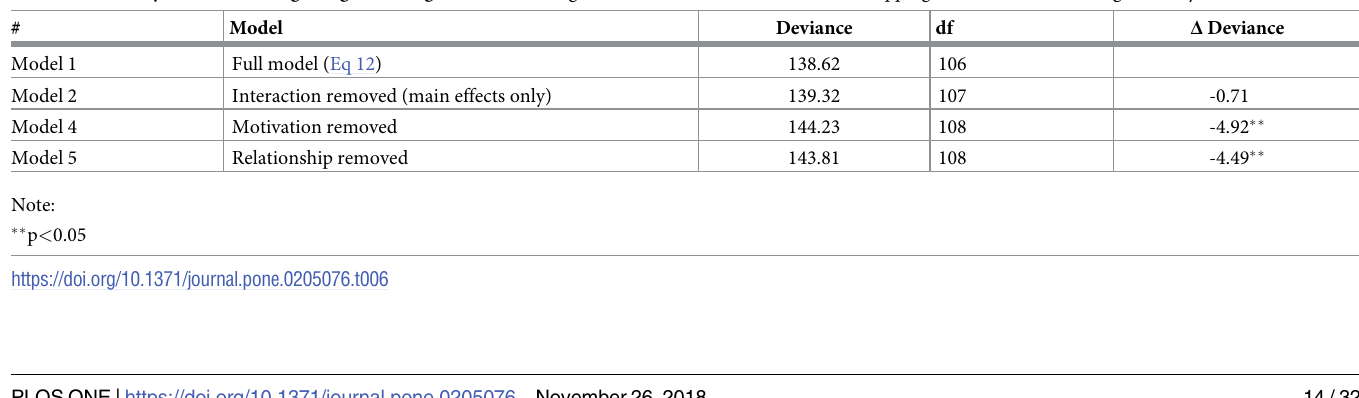
Table 6. Summary of model testing using the change in deviance. Significant outcomes indicate that the dropping of a term results in a significantly worse